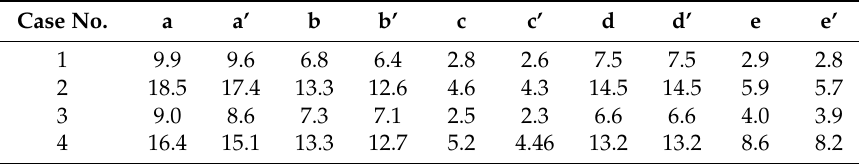
Table 12. Total displacement (mm) at different points along the tunnel perimeter with and without